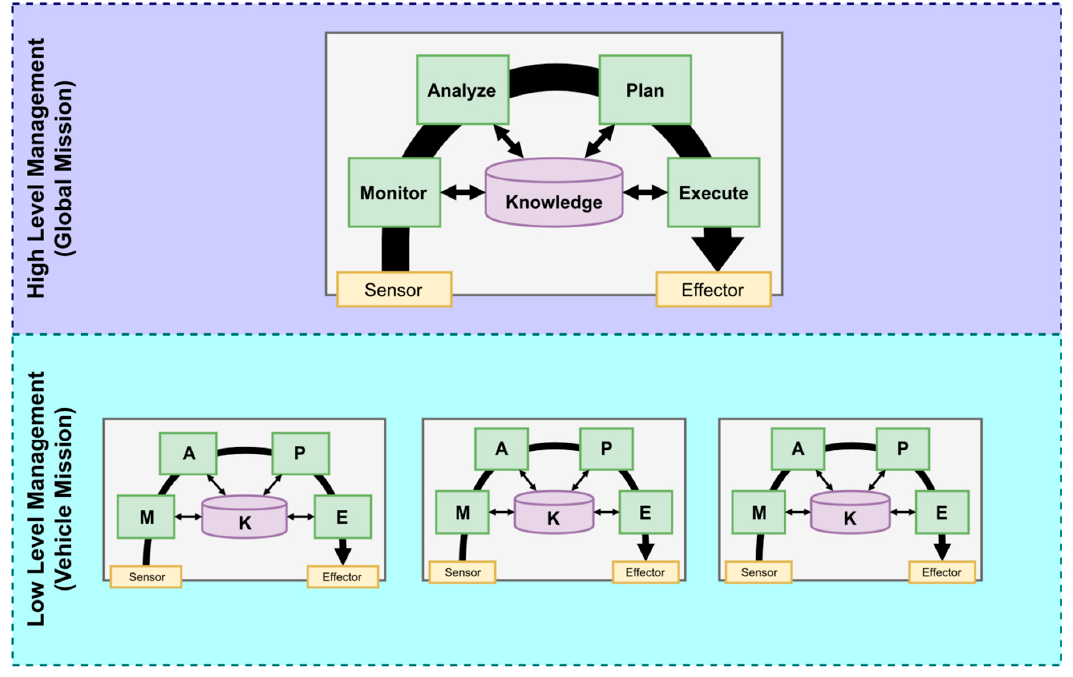
Figure 4. An example of a hierarchy of MAPE-K autonomic managers with a two-level hierarchy. Iglesia et al. [42] proposed a set of formal templates for the design of self-adaptive systems, and